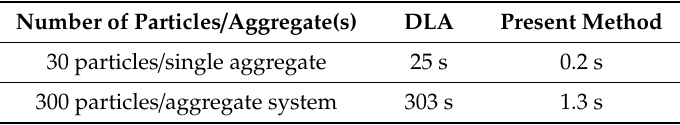
Table 1. Time required to construct an aggregate and an aggregate system, with the Di ff usion-limited Aggregation (DLA) method and with the present